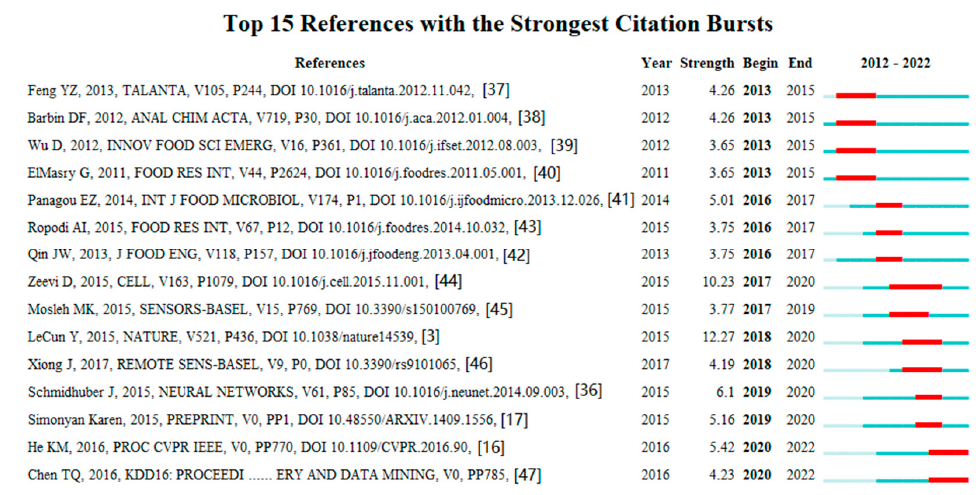
Figure 6. The co-citation network of AI-related publications.